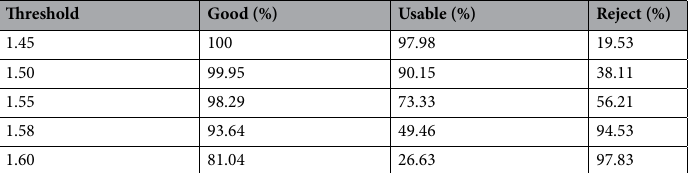
Table 1. Multi-class classification accuracy of EyeQ test set using proposed method. For each quality class (“Good”, “Usable” or “Reject”), a quality threshold is applied to filtering out negative images and compute corresponding